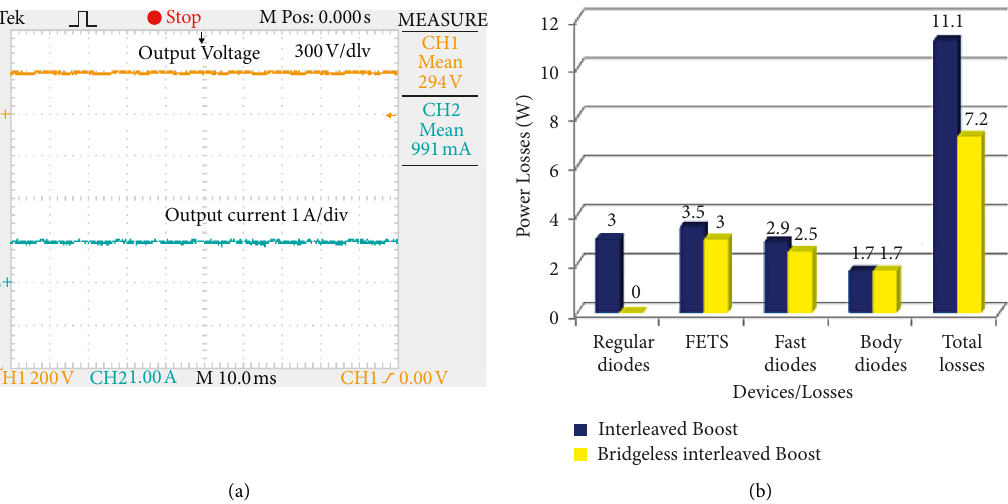
Figure 12: (a) Output voltage and output current waveform for 300W. (b) Device loss distribution for interleaved boost and BLIL boost converter for 300W prototype.